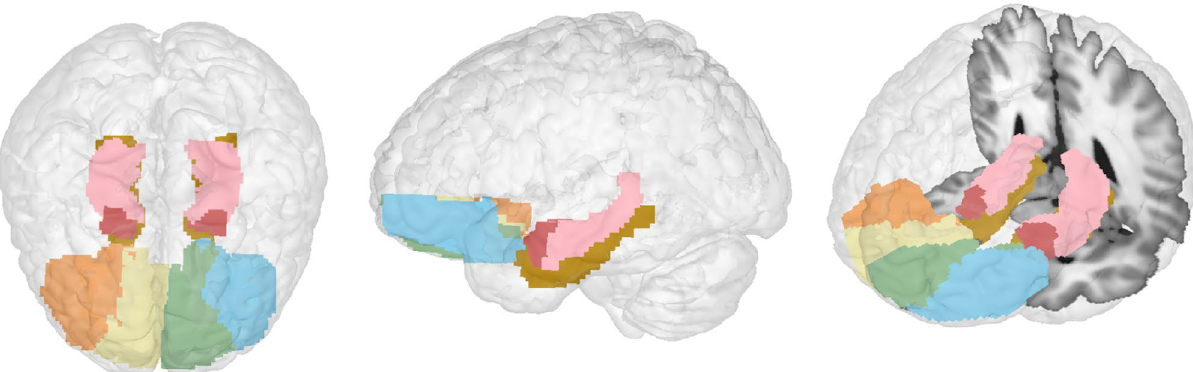
Figure 1. Anatomical regions of interest used in the resting-state functional connectivity and grey matter volume analyses. Left: Top view of all regions of interest. Middle: Left side view. Right: Left side view tilted with slice for reference. Dark pink-bilateral amygdala, orange-right lateral OFC, yellow-right medial OFC, green-left medial OFC, blue-left lateral OFC, light pink-hippocampus, brown-parahippocampal